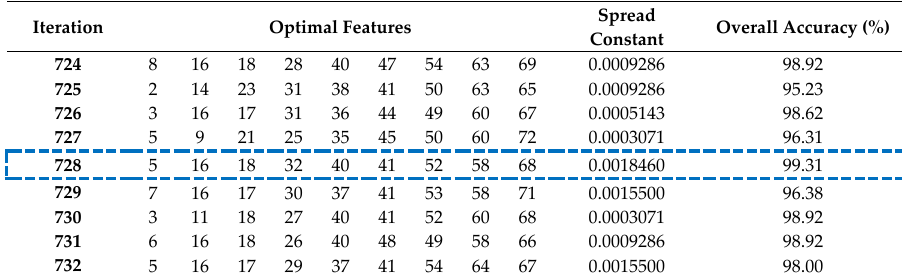
Table 5. The classification accuracy and the selected features by the adaptive ABC-PSO algorithm as a function of iteration number and spread constant.